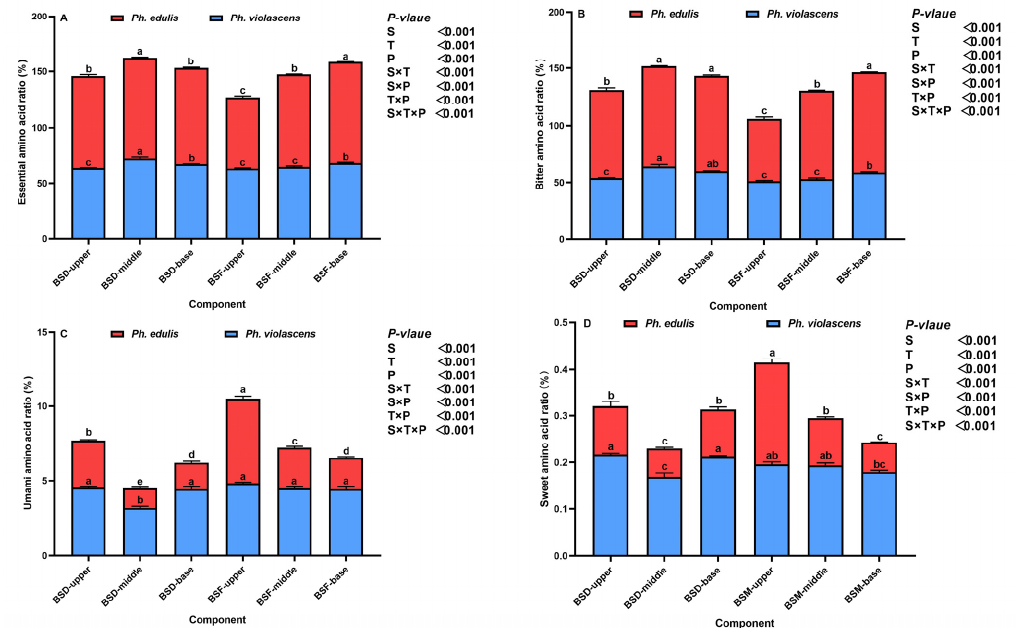
Figure 5. Proportional changes in amino acid composition in bamboo shoot diaphragm (BSD) and flesh (BSF) of Ph. edulis and Ph. violascens . ( A ) Essential amino acid ratio, ( B ) bitter amino acid ratio, ( C ) umami amino acid ratio, and ( D ) sweet amino acid ratio. BSD and BSF refer to bamboo shoot diaphragm and flesh, respectively. Vertical bars are means ± SD of the four replicates. Different lowercase letters above the bars in each graph represent significant differences at p < 0.05 between the bamboo shoot segments. p values are only shown for the main and interactive effects of species (S), components (C), and positions (P), respectively, of each indicator.